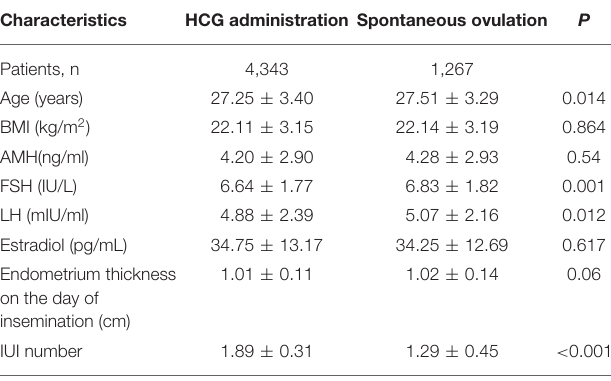
TABLE 1 | Demographic characteristics of the patient population.